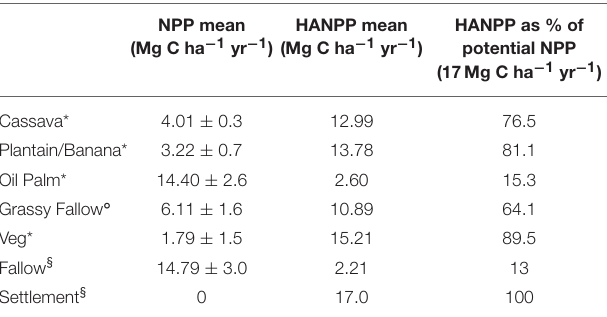
TABLE 2 | Mean NPP and HANPP values for land uses within the study